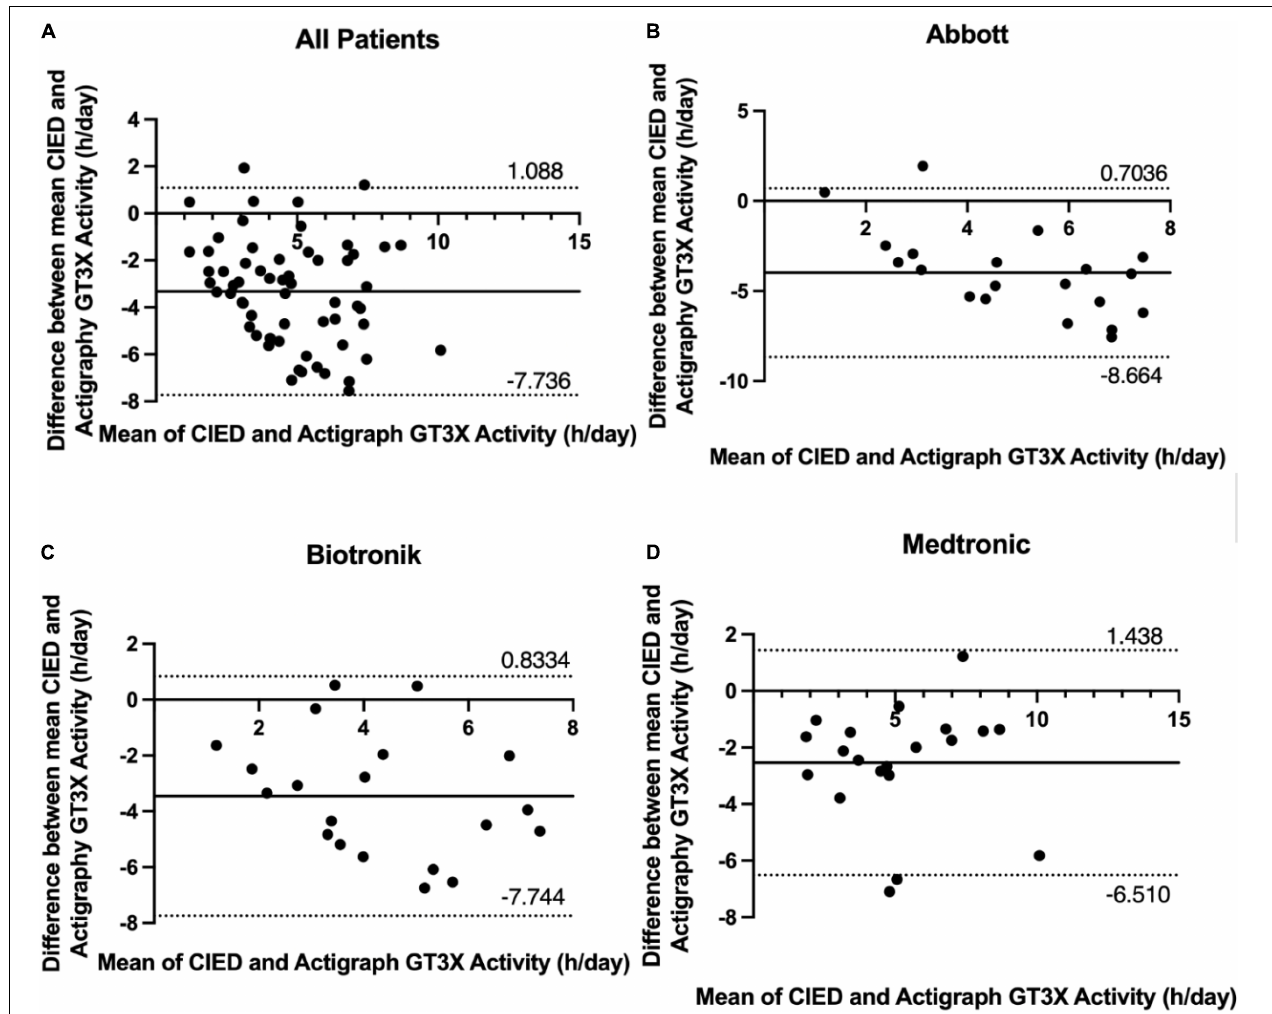
FIGURE 3 | Bland-Altman difference plot of device- and ActiGraph-measured 7-day average physical activity (hours per day) with 95% limits of agreement ( ± 1.96 SD). (A) All patients, (B) Abbott, (C) Biotronik, (D) Medtronic.